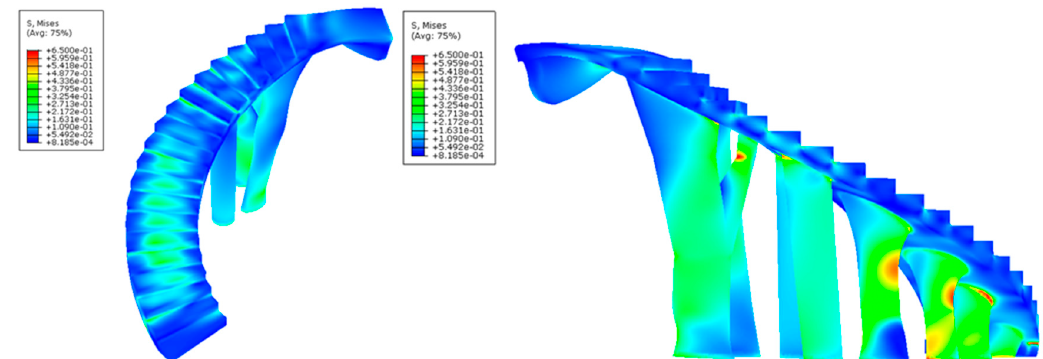
Figure 25. Field of the von Mises stress (MPa) obtained in the mechanical simulations: the BIM building element E 1 indicated in two perspectives in the left and right pictures.